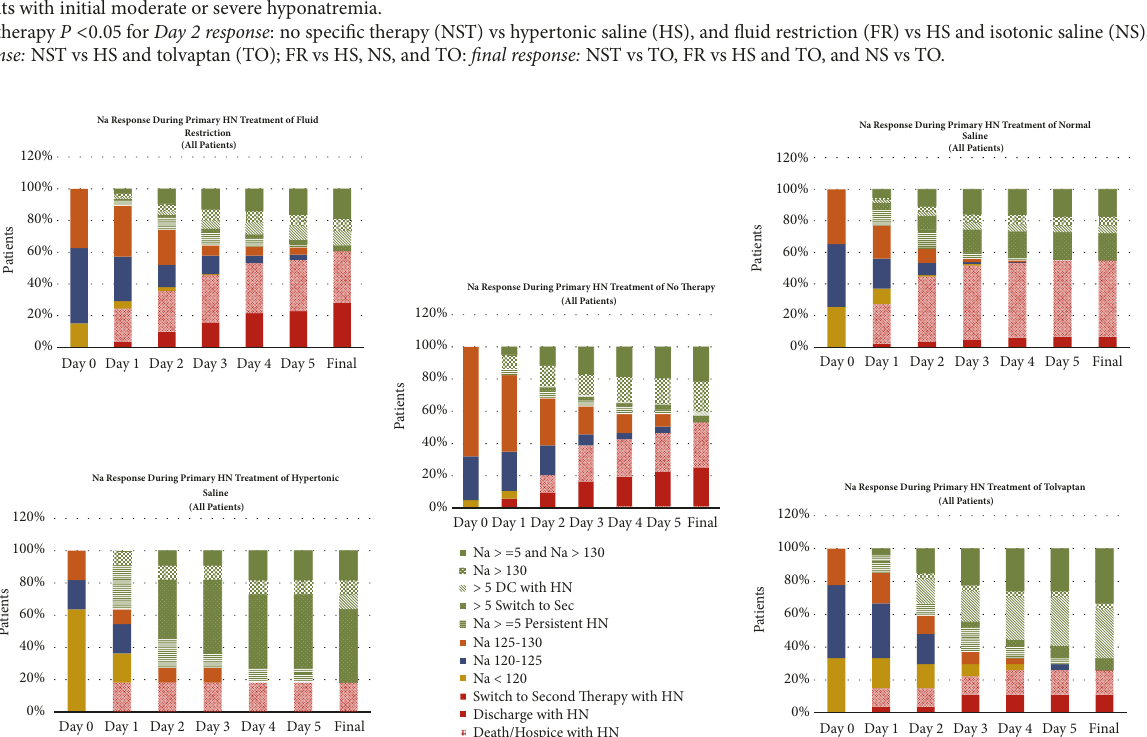
HN (mild: 31 [40%]; moderate: 8 [10%]; and severe: 0), and 12 (16%) died during hospitalization or were discharged to